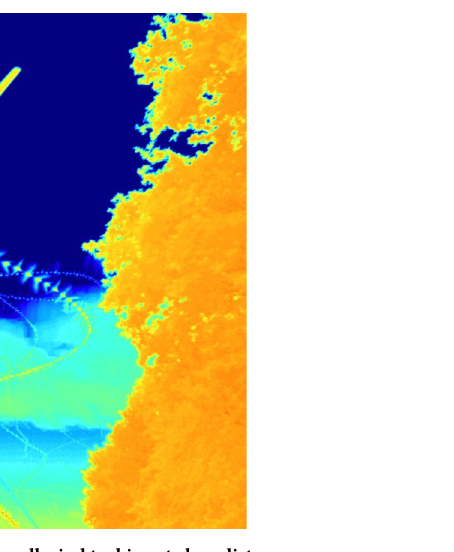
Fig 2. Example of a bat passing the rotor blades of a small wind turbine at close